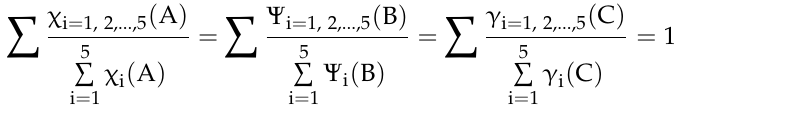
Table 3. Table illustrating evidence fusion from two sources χ i ( A ) and Ψ i ( B ) . Sources of Evidence